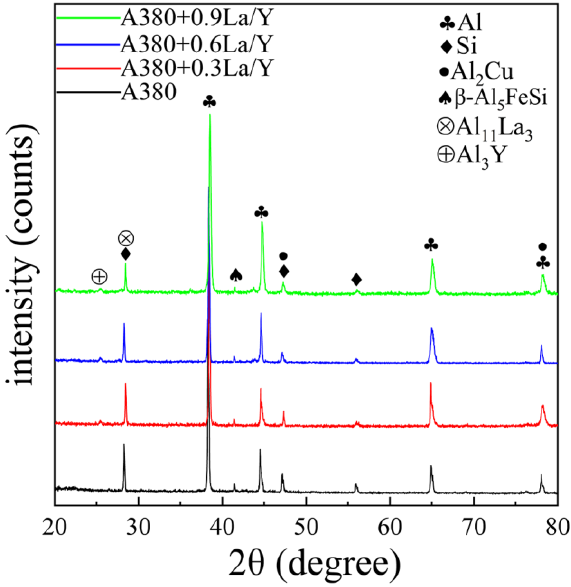
Figure 5. XRD patterns of A380 alloys with different (La+Y)